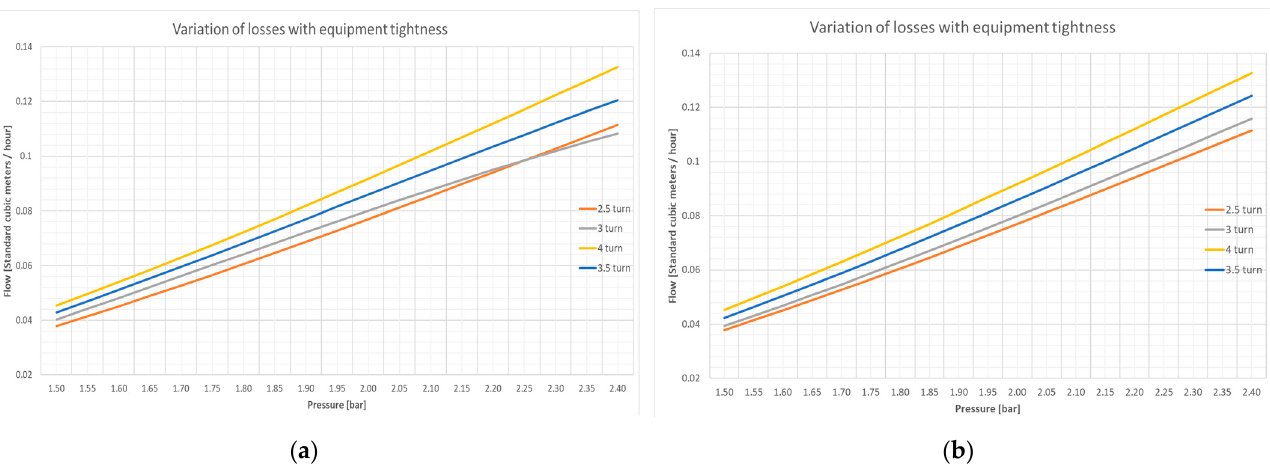
Figure 8. Correction of a flow rate variation curve with pressure and leakage faulty fitting ( a ) real data curve; ( b ) revised curve. (source: authors based on the analysed data).